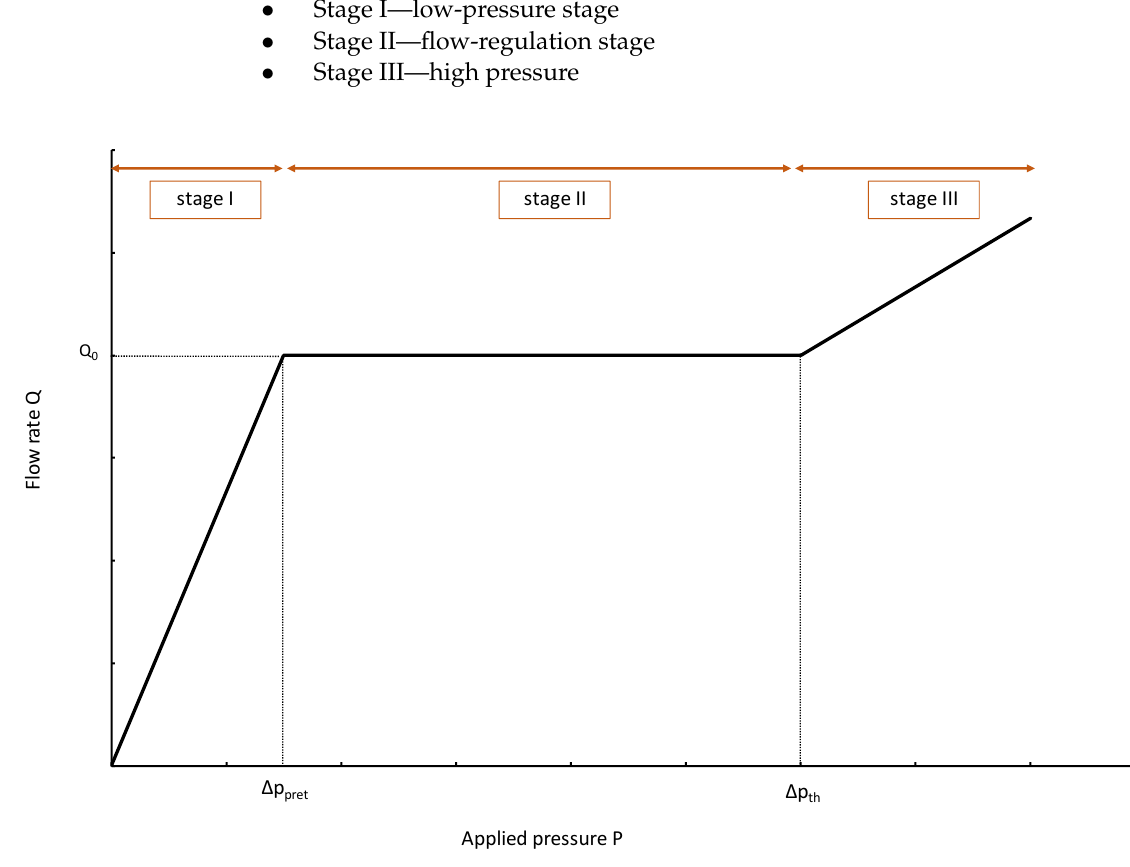
Figure 4. Ideal flow rate versus pressure gradient characteristic of a three-stage passive constant flow regulator. At low pressure (Stage I), the regulator has a constant and low hydraulic resistance. In Stage II, the flow is regulated at Q 0 for a pressure gradient in the range [ ∆ P pret ; ∆ P th ]. At high pressure (Stage III), the device delivers a large flow rate.